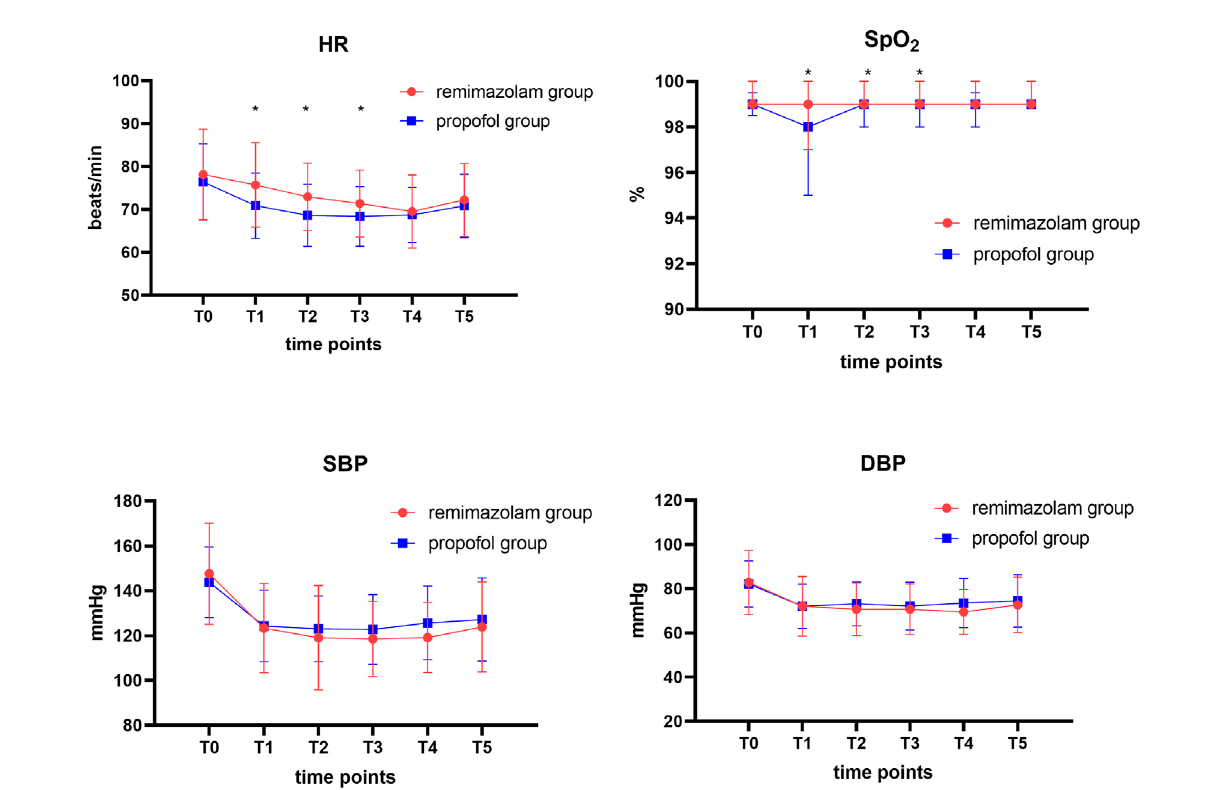
FIGURE 3 Comparison of hemodynamic pro fi les and oxygen saturation levels in two groups at different time points. Data are expressed as mean ± SD or median [IQR]. HR, heart rate; SBP, systolic blood pressure; DBP, diastolic blood pressure. T0, before administration of intravenous sufentanil; T1, 5 min after administration of intravenous remimazolam or propofol; T2, 10 min after administration of intravenous remimazolam or propofol; T3, 15 min after administration of intravenous remimazolam or propofol; T4, 20 min after administration of intravenous remimazolam or propofol; T5, end of the gastrointestinal endoscopy. The Wilcoxon-Mann-Whitney test was used to compare the differences in oxygen saturation between the two groups of patients. * p < 0.05 considered a statistical difference between the two groups.